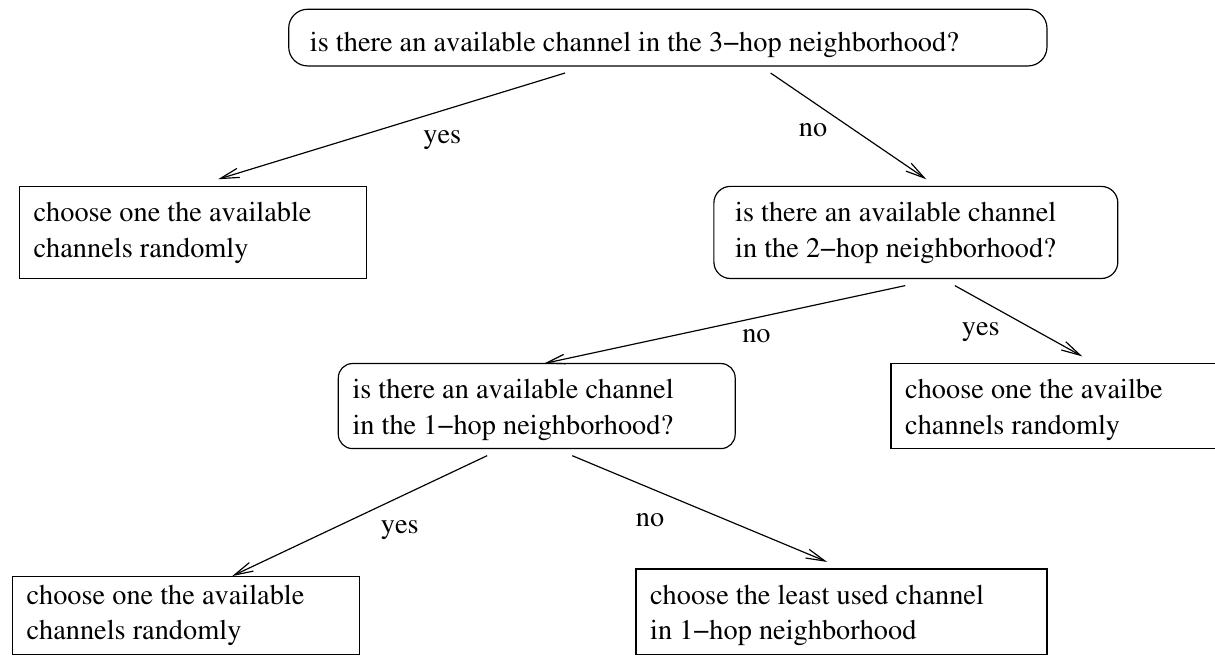
Figure 5. Algorithm for choosing the a